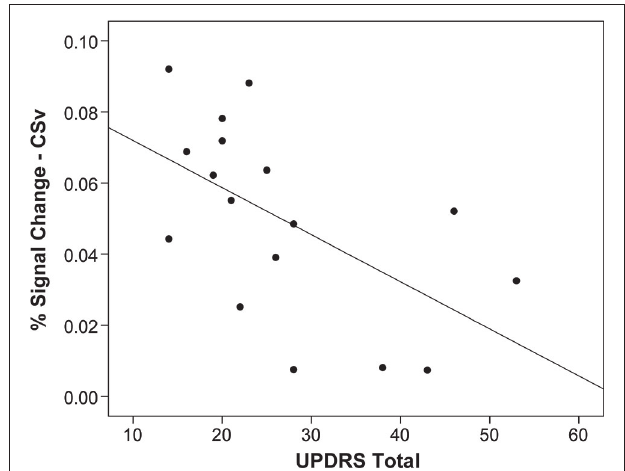
FIGURE 3 | Activation in CSv related to disease severity . Activation in response to optic flow in area CSv is correlated with disease severity measured by the Unified Parkinson’s Disease Rating Scale (UPDRS; r = 0.56, p = 0.02), such that worse disease severity is associated with less activation. Each point on the plot represents one individual with Parkinson’s